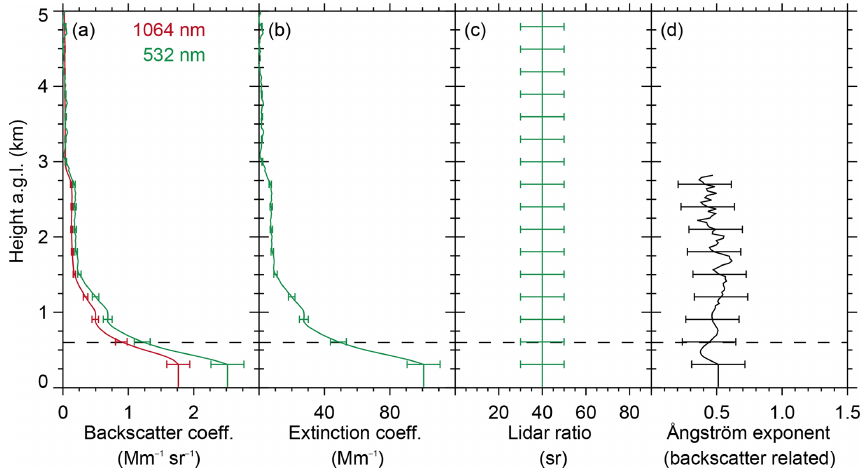
Figure 10. Vertical profiles of (a) particle backscatter coefficient at 532 and 1064nm, with error bars indicating 10% uncertainty, (b) particle extinction coefficient at 532nm, with error bars resulting from a lidar ratio uncertainty of ± 10sr, (c) particle lidar ratio with error bars of ± 10sr and (d) backscatter-related Ångström exponent, with propagated error bars, derived by Polly XT on 17 February 2010, 02:00 to 06:00UTC. The planetary boundary layer top height is indicated by the dashed black line.